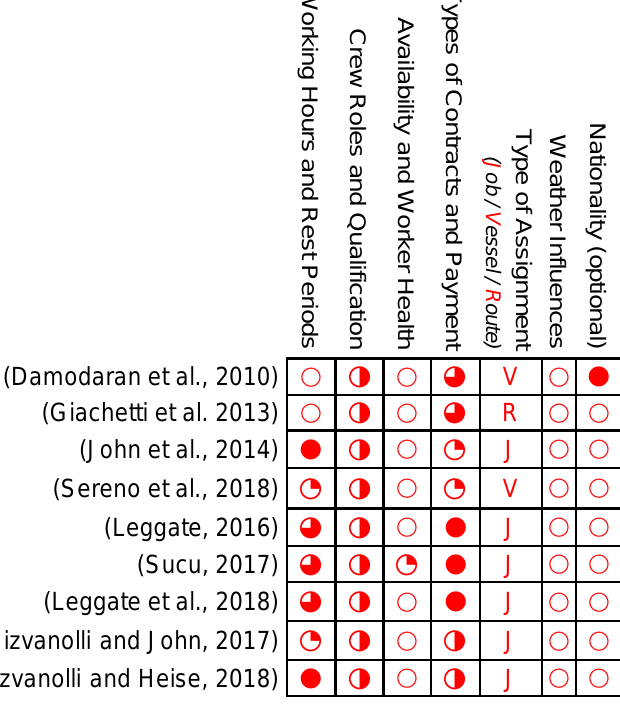
Figure 3. Results after evaluating existing models against the